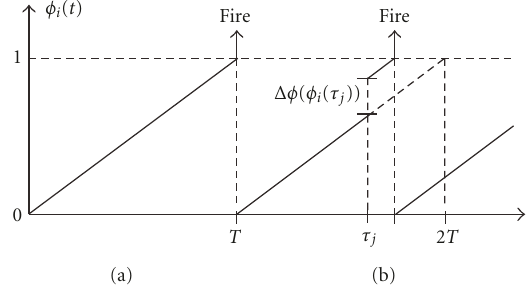
Figure 1: (a) Uncoupled phase function and (b) phase increment upon reception of a